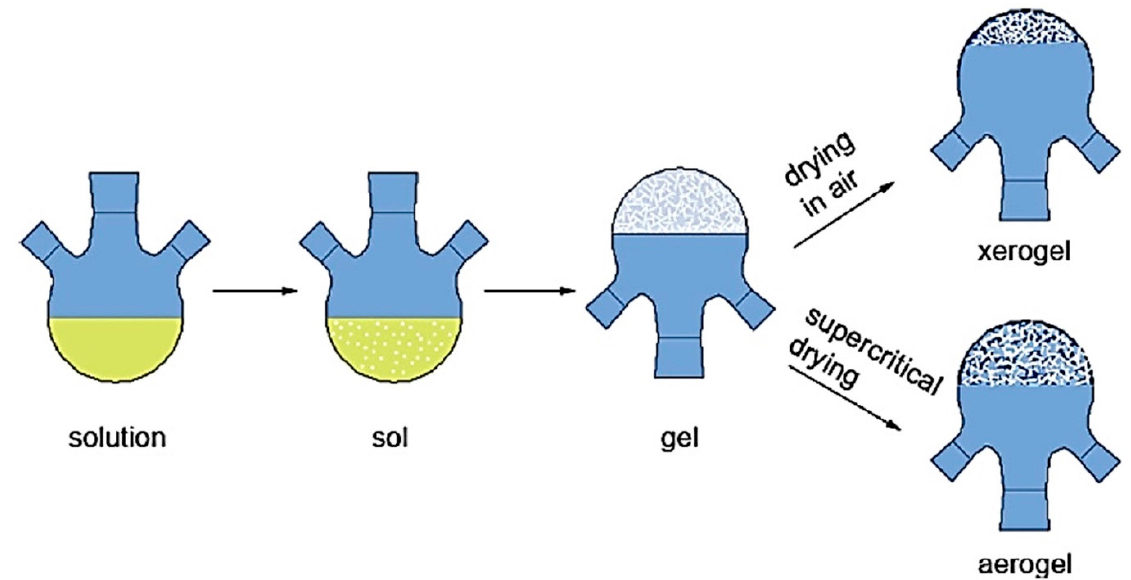
Figure 6. Graphical illustration of sol formation in liquid phase, infinite viscosity of gel, shrinkage of xerogel and an aerogel without shrinkage. Reprinted with permission from Reference [64]. Copyright 2012, with permission from American Chemical Society.